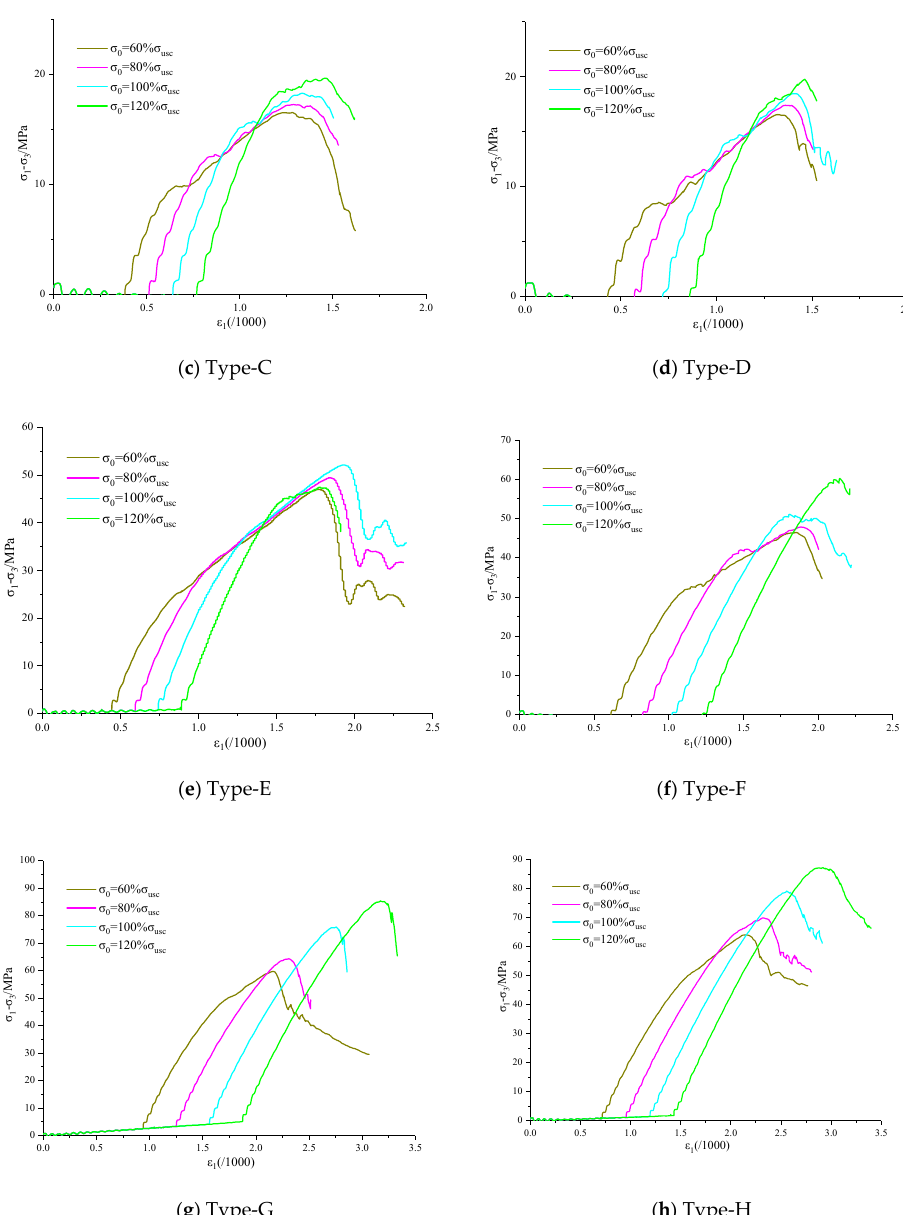
Figure 15. The numerically-predicted axial deviatoric stress–axial strain curves of different marble specimens under unloading conditions with various initial confining pressures.